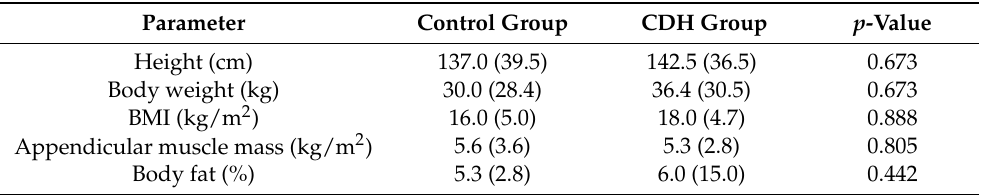
Table 2. Anthropometric data of the patients in the CDH and control group. Data presented as medians (IQRs) and the Mann–Whitney U test was performed for group